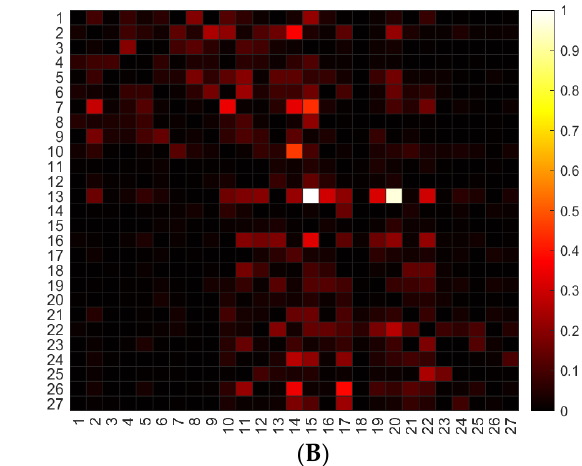
Figure 2. ( A ) Subject 11 DC of healthy class in the alpha band. ( B ) Subject 10 (Total Unified Par- kinson’s Disease Rating Scale (UPDRS) = 22) DC of Parkinson class in the alpha